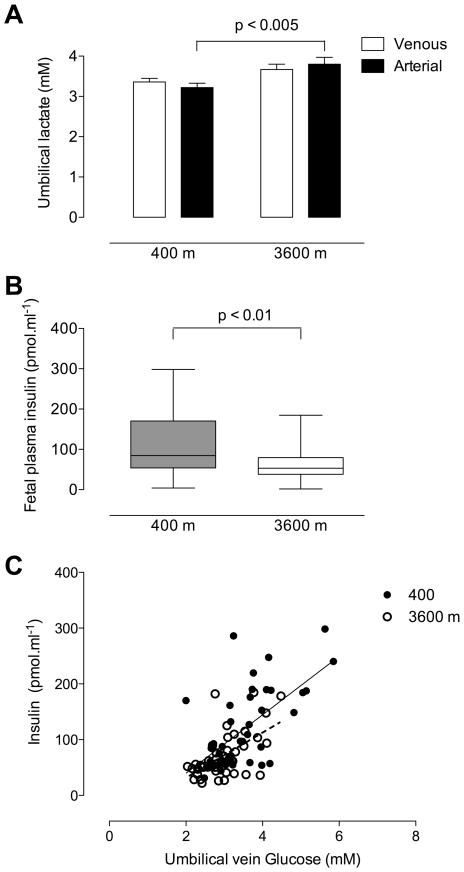
Fetal lactate and insulin response to altered glucose delivery and consumption.(A) Umbilical venous plasma lactate concentrations in normal, term pregnancies at 400 vs 3600 m did not differ (3.36±0.09 mM at 400 m and 3.67±0.13 mM at 3600 m, p = 0.06), whilst arterial concentrations were lower at 400 m (3.22±0.11 mM) than at 3600 m (3.80±0.17, p<0.005). (B) Insulin concentrations were greater in the low vs. high altitude fetus (low altitude, median  = 84.7 pmol.ml−1 [54.1–170.1]; high altitude, median  = 53.5 pmol.ml−1 [38.2–79.2]). (C) Fetal glucose and insulin concentrations were positively correlated at both altitudes (400 m y  = −65.2+52.4x r2 = 0.34, p<0.0001; 3600 m y  = −49.4+40.5x, r2 = 0.33, p<0.0001) but neither the slopes (p = 0.42) nor intercept (p = 0.11) differed.